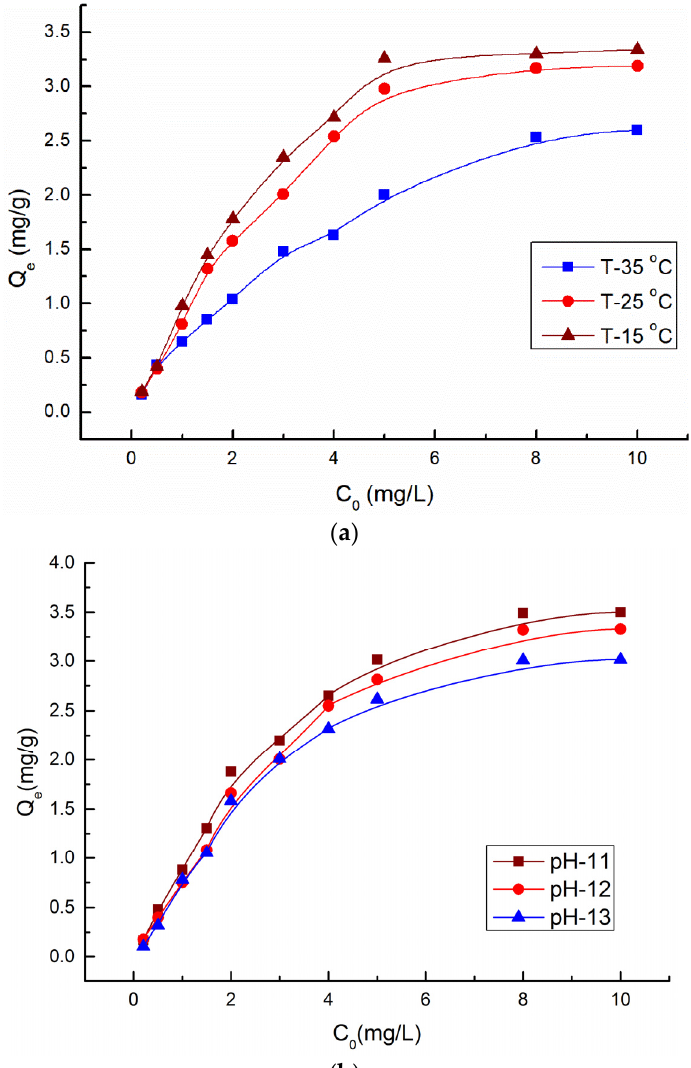
Figure 6. Effect of temperature and pH on adsorption of dissolved lead by calcium chloroaluminate. ( a ) Effect of temperature on adsorption of dissolved lead by calcium chloroaluminate. ( b ) Effect of pH on adsorption of dissolved lead by calcium chloroaluminate.